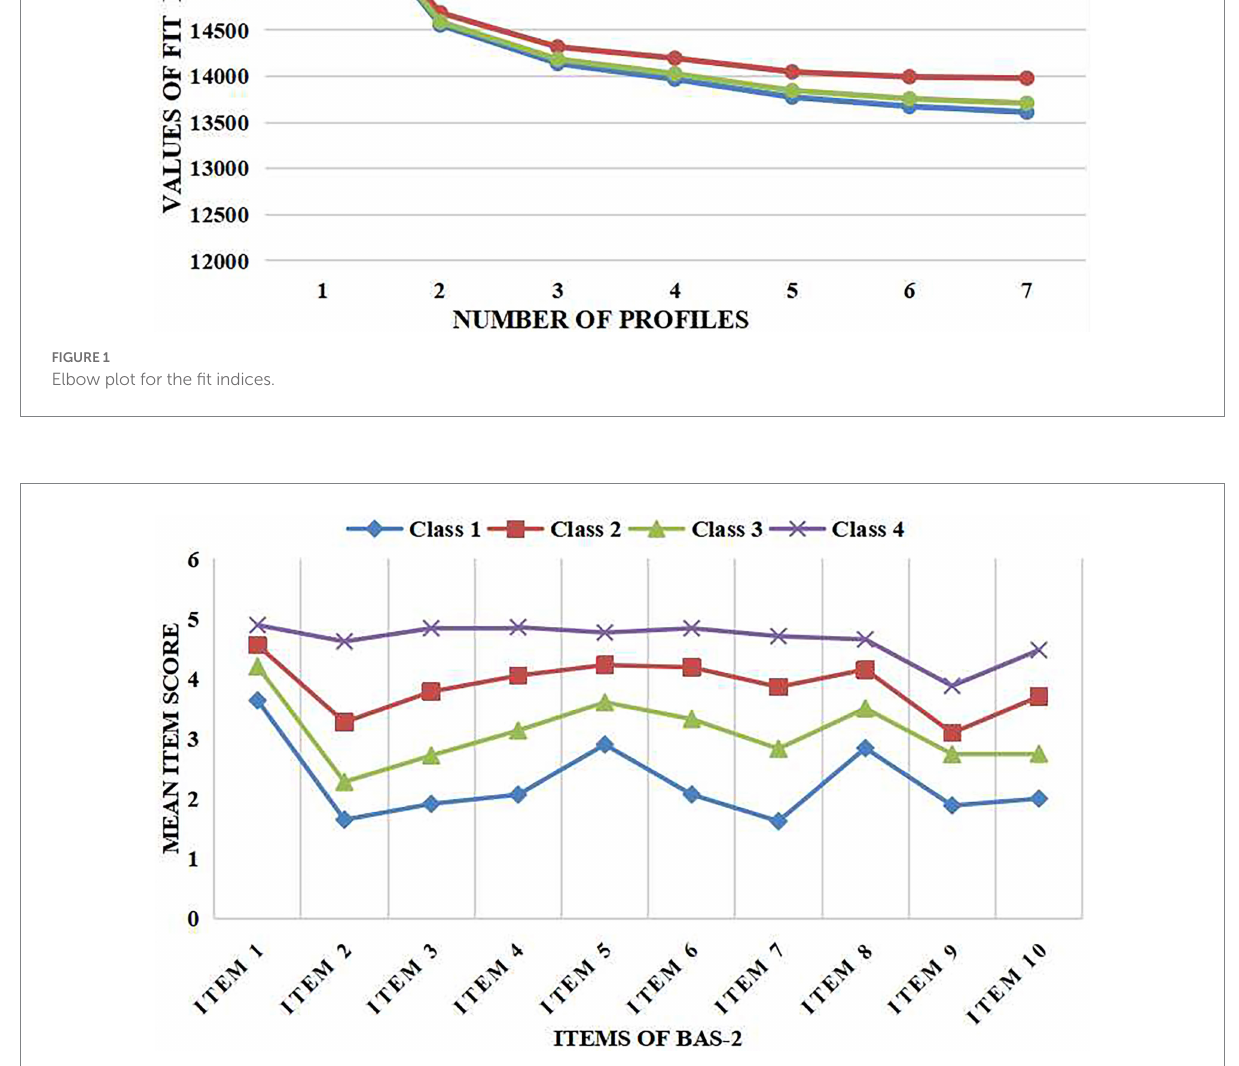
FIGURE 2 Item means for the fourth profile model of body